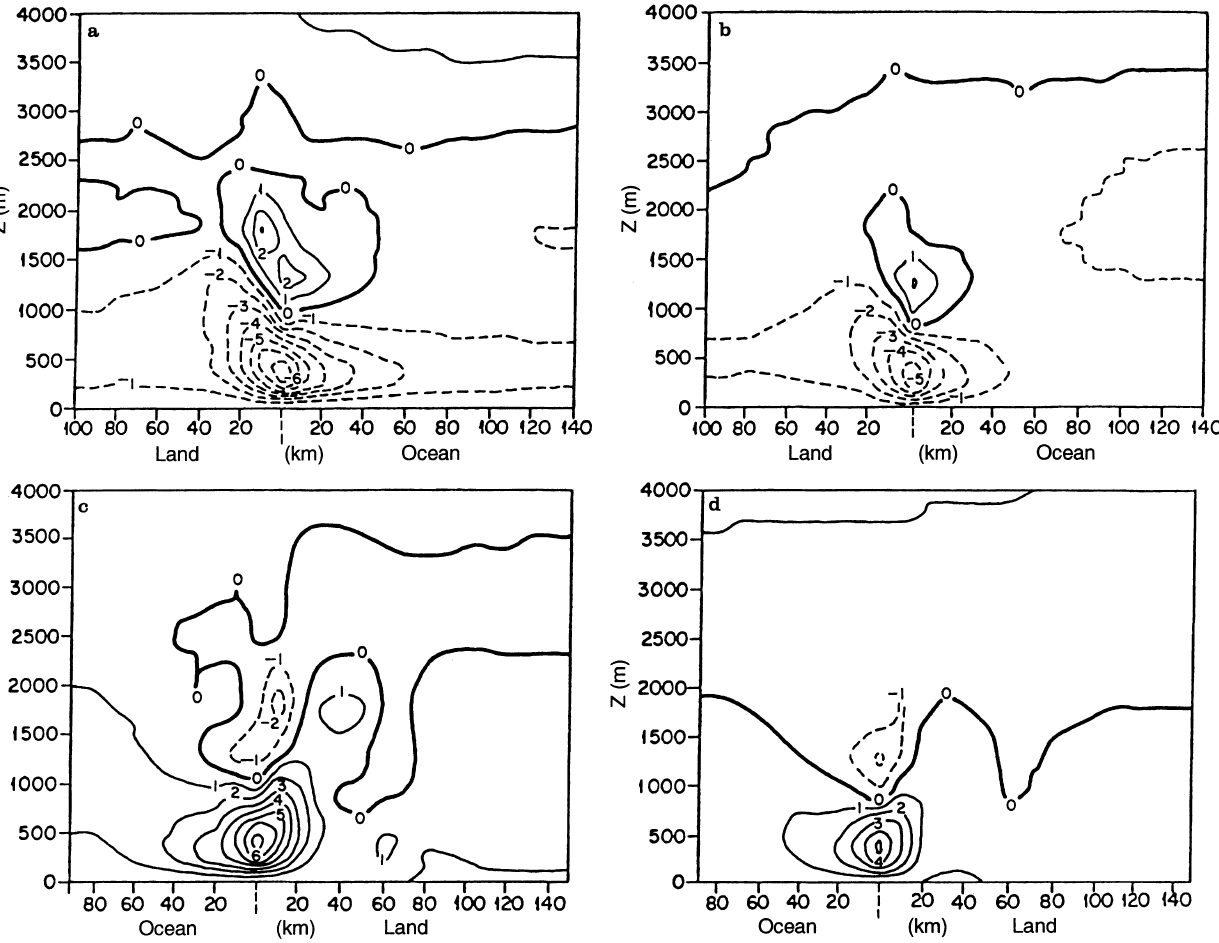
Fig. 7a–d. Cross section of the simulated horizontal wind at 15:00 LT: a EW variation of the u -component along line AB (Fig. 1) for OND; b same as a , except for AMJ; c SN variation of the v-component along line CD (Fig. 1) for OND; and d same as c , except for AMJ. Units are m s (cid:255)